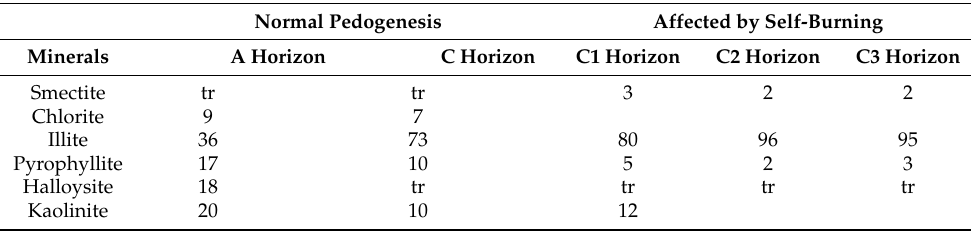
Table 5. Mineralogical composition (%) of clay fractions of soil horizons from S ã o Pedro da Cova mine waste pile. Normal Pedogenesis Affected by Self-Burning Minerals A Horizon C Horizon C1 Horizon C2 Horizon C3